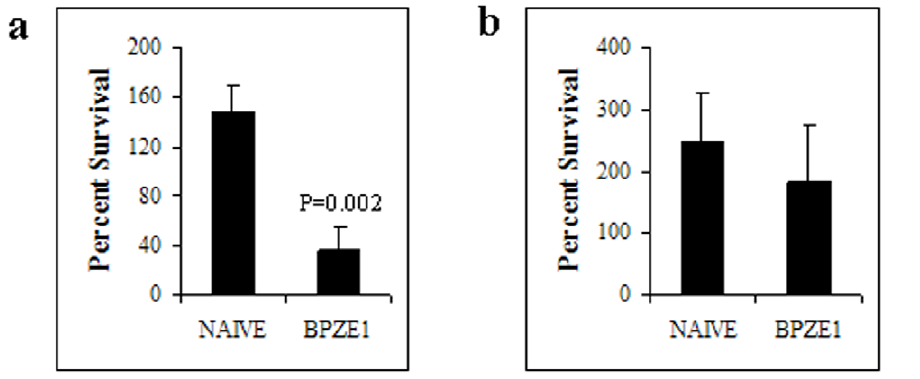
Figure 8. Survival of B.pertussis and B.parapertussis in the presence of serum from non-immune or BPZE1-immunized mice. 300 CFU of B. pertussis ( a ) and B. parapertussis ( b ) were incubated at 37 u C for 1 h in the presence of 100 m l of 80% serum from unimmunized (Naı¨ve) or BPZE1- immunized (BPZE1) mice and then plated onto Bordet Gengou blood agar plates for CFU counting. The results are presented as percent survival relative to that of a PBS control (in the absence of serum) ( 6 standard error) for 3 mice per group, evaluated on 3 different plates per mouse, and are representative of three independent experiments.